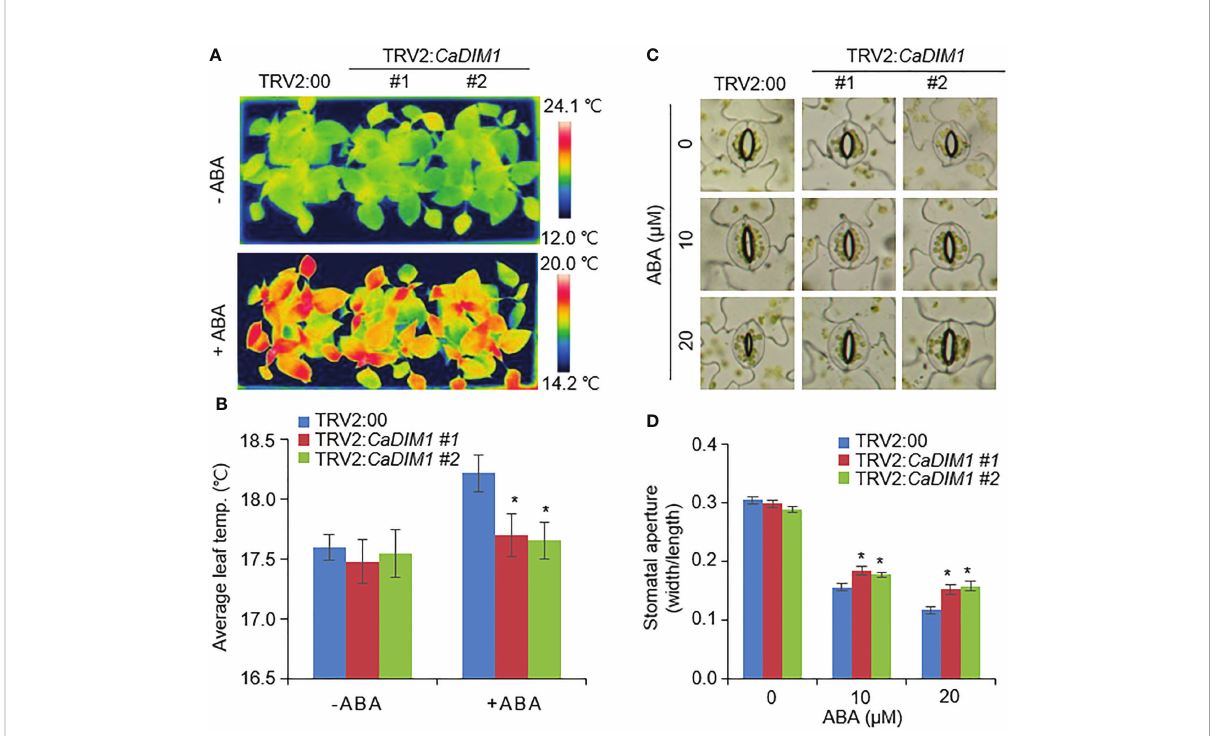
FIGURE 3 Reduction of ABA-mediated stomatal closure in the leaves of CaDIM1 -silenced pepper plants. (A, B) Leaf temperatures of TRV2:00 and TRV2: CaDIM1 plants before and after exposure to ABA. Leaves from the plants of each line were sprayed with 0 and 100 m M ABA. At 3 h after treatment, representative thermographic images were taken (A) and leaf temperature was measured (B) . (C, D) ABA-induced stomatal closure in TRV2:00 and TRV2: CaDIM1 plants. Leaf peels were incubated with 0, 10, and 20 m M ABA. Representative images were taken (C) and the stomatal aperture of each line was measured 3 h after treatment (D) . All data represent the mean ± standard error of three independent experiments. Asterisks indicate signi fi cant differences between TRV2:00 and TRV2: CaDIM1 plants (Student ’ s t -test; * P <